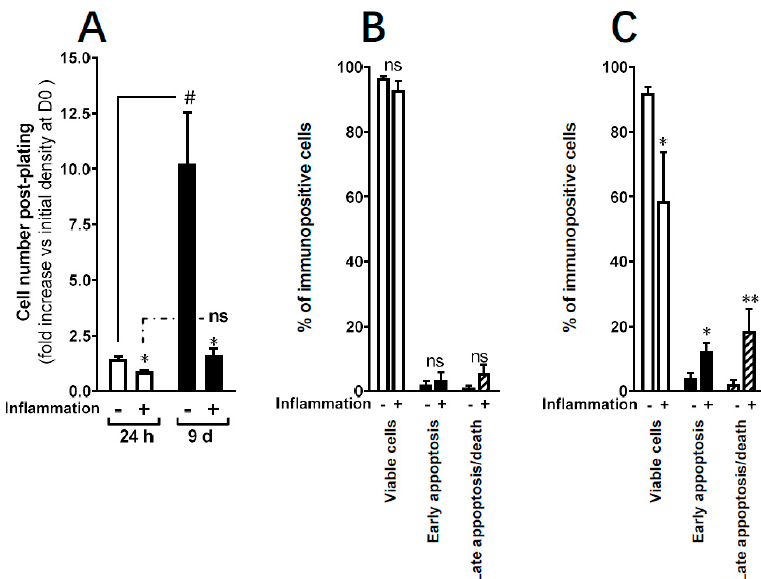
Figure 2. Effect of inflammation on ADHLSC viability in culture. ( A ) Significant decrease in adherent ADHLSC number after 24 h and 9 days treatment with the inflammation cocktail ( n = 4 samples from different donors for each timepoint). Results are expressed as mean ± standard error of the mean (SEM). * p value < 0.05. # p < 0.05 control-9-day inflammation vs. control-24 h inflammation, one-way